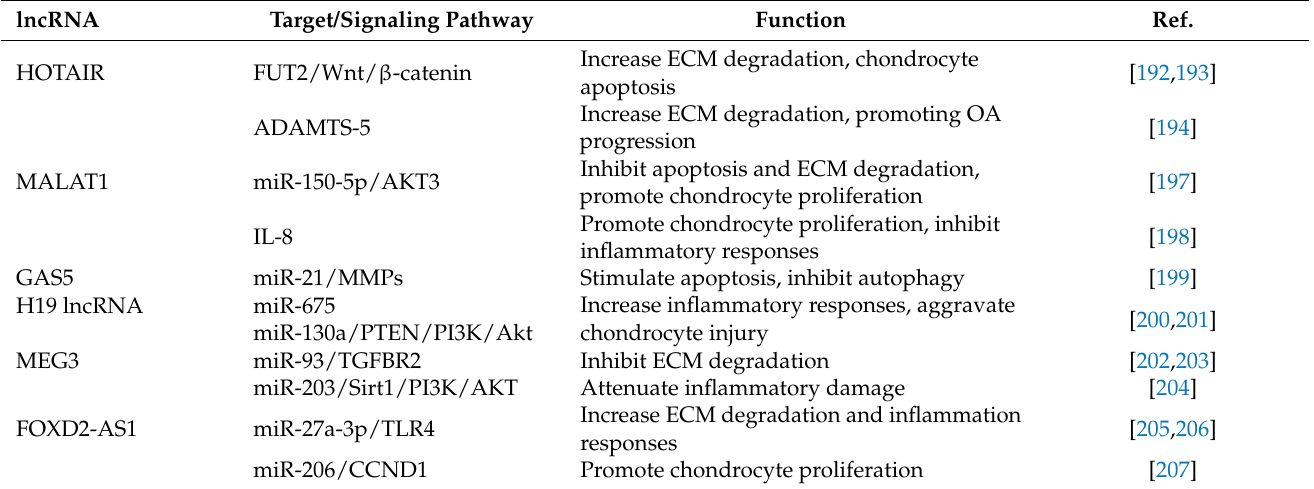
Table 3. Classifications and biological functions of lncRNAs in